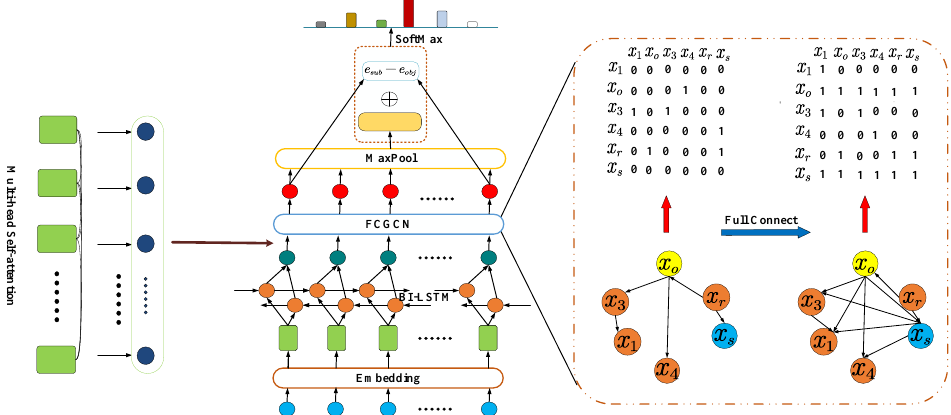
Figure 1. FCGCN model architecture diagram. The left part shows the overall architecture of FCGCN, and the right part shows FCGCN’s entity-centric fully connected logical adjacency matrix, where x o , x s represents the physical node and x r represents the root